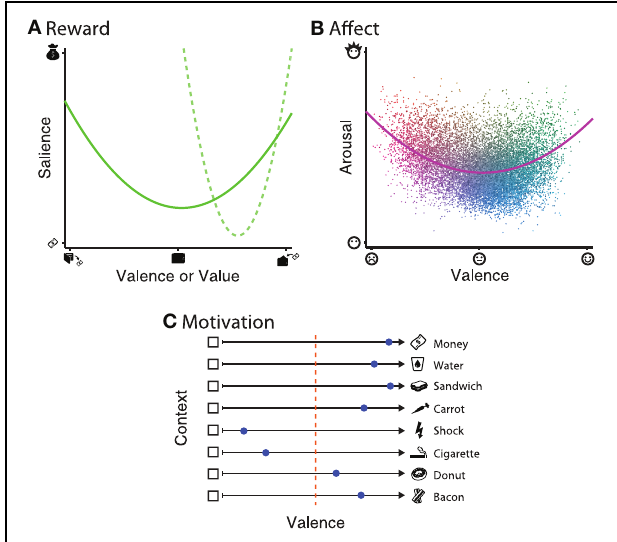
FIGURE 1 | Illustrations of the dimensionality of each of the three constructs. (A) Reward: the solid line denotes that reward salience has a quadratic relationship relative to reward valence. Recent results have also shown that this relationship can be observed even when the range of values experienced is constrained to either the gain or loss domain, as in the dashed line. (B) Affect: each dot represents a word from a large normative database Warriner et al. (2013). Dot color varies between blue–yellow (based on arousal) and red–green (based on valence), with variability in luminance added to improve item discriminability. The solid line represents a quadratic model fit to all words in the database. (C) Motivation: approach–avoidance tendencies are context-dependant, based on not only stimulus itself, but also the current state of the individual (e.g., thirst, hunger) and inter-individual differences (e.g., economics status, smoker, dieter, vegetarian). Individual preference within a given context are denoted by the blue dots, and range from approach (dot closer to the stimulus) to avoid (dot closer to the empty box). The orange dotted line denotes the point of